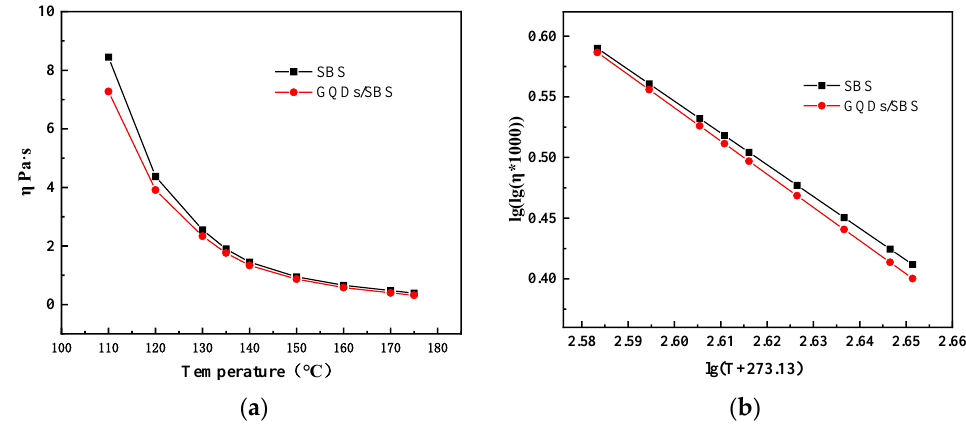
Figure 6. Viscosity – temperature performance of SBS and GQDs/SBS composite-modified asphalt. ( a ) Viscosity -temperature curve; ( b )Viscosity temperature curve after fitting with Saal formula. The Saal model (Equation (1)) proposed by ASTM D2493 was further applied to process the viscosity–temperature curves. It can characterize the temperature sensitivities of the GQDs/SBS composite-modified asphalt and SBS-modified asphalt.